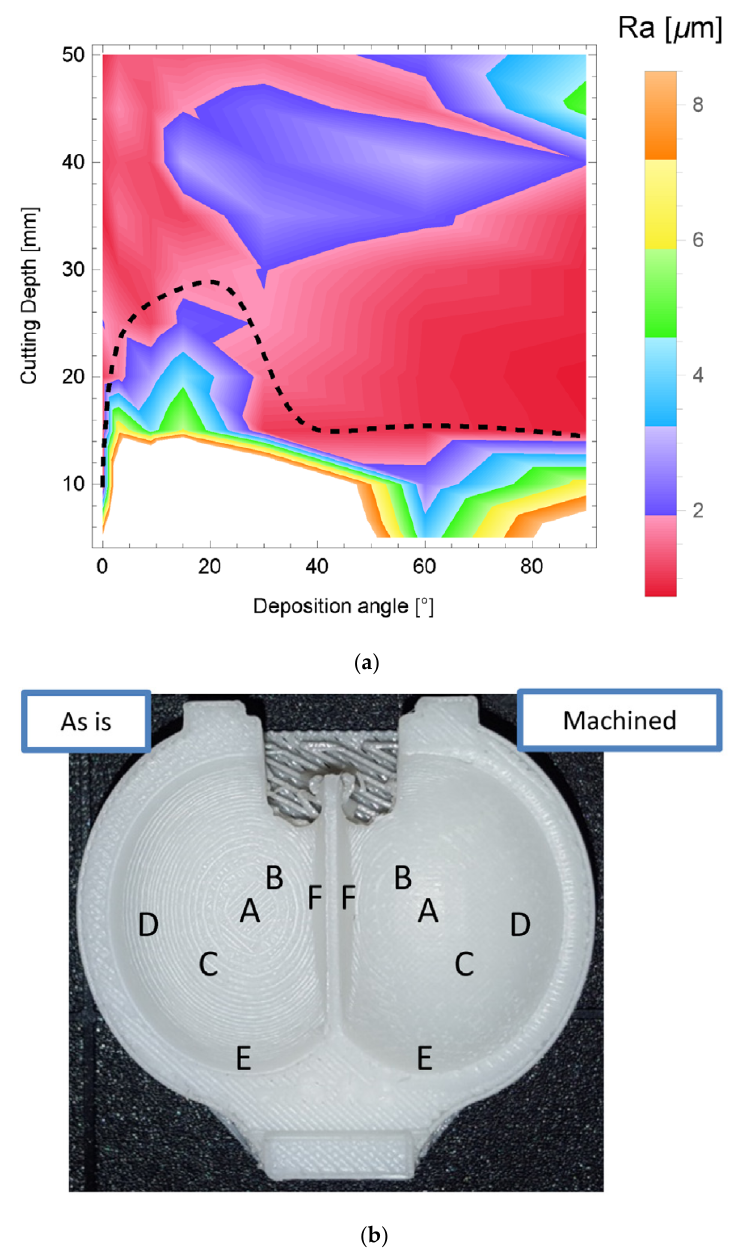
Figure 14. ( a ) Surface roughness as a function of the deposition angle and cutting depth; ( b ) resultant surface finish versus unmachined surface [27].